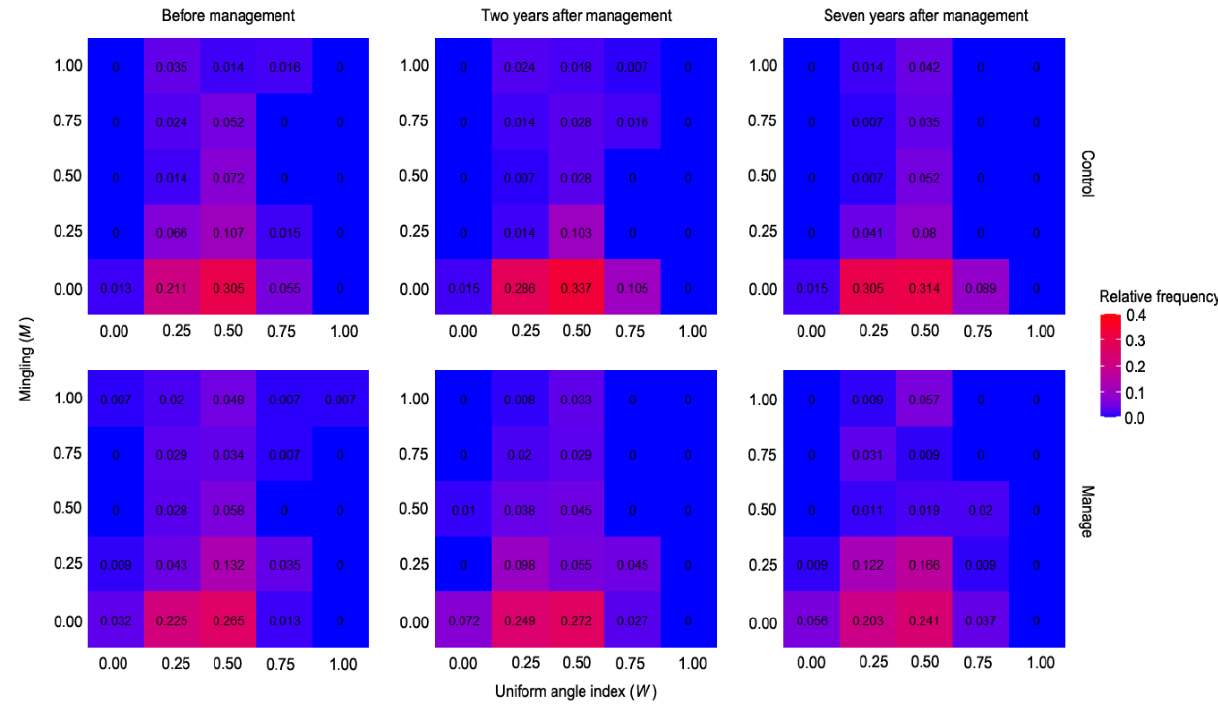
Figure 5. Bivariate distributions of 𝑊 and 𝑀 at different management years.